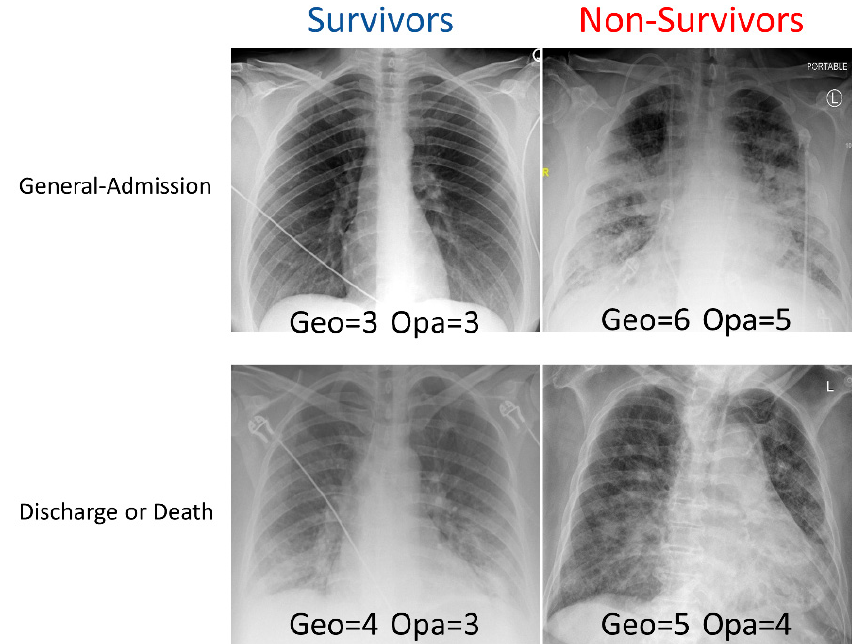
Figure 1. Examples of CXRs with different geographic extent and opacity scores. CXRs of COVID-19